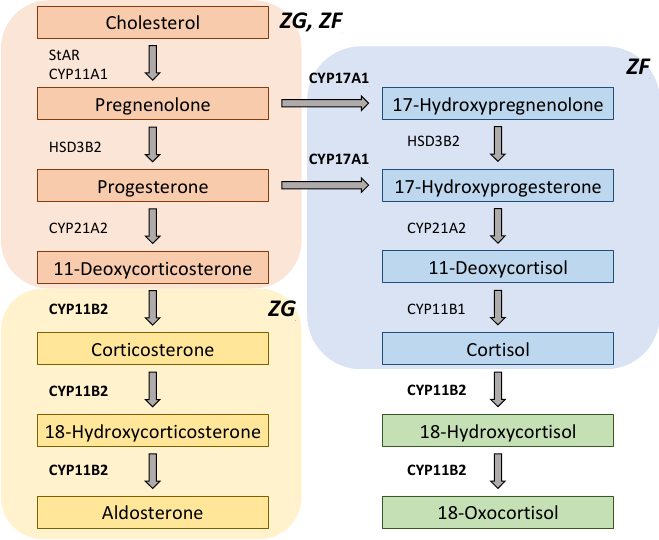
Figure 2. Scheme of steroidogenic pathways for aldosterone, 18-oxocortisol, and 18-hydroxycortisol. Both CYP11B2 (aldosterone synthase) and CYP17A1 (17α-hydroxylase/17,20-lyase) are required to synthesize 18-oxocortisol and 18-hydroxycortisol. Thus, plasma levels of 18-oxocortisol and 18-hydroxycortisol are likely to be higher in patients with KCNJ5 -mutated aldosterone-producing adenoma (APA), while they are very low in normal adults. CYP11A1: cytochrome P450 cholesterol side-chain cleavage; CYP11B1: 11β-hydroxylase; CYP21A2: 21-hydroxylase; HSD3B2: 3β- hydroxysteroid dehydrogenase type 2; StAR: steroidogenic acute regulatory protein; ZF: zona fasciculata; ZG: zona glomerulosa.